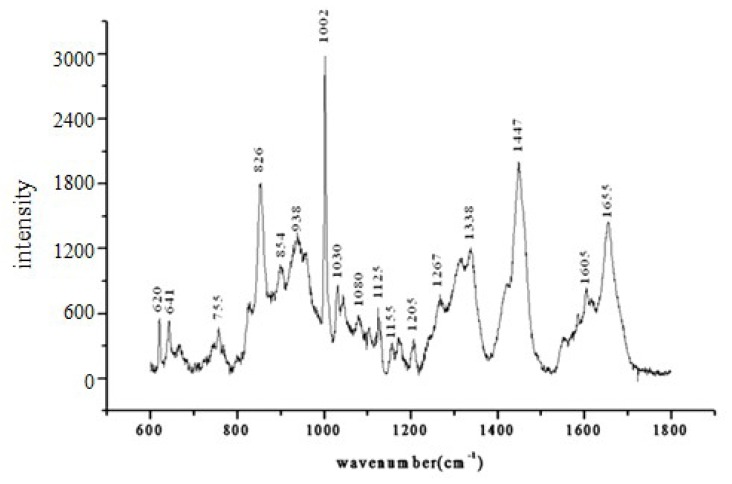
The average spectrum of all samples.